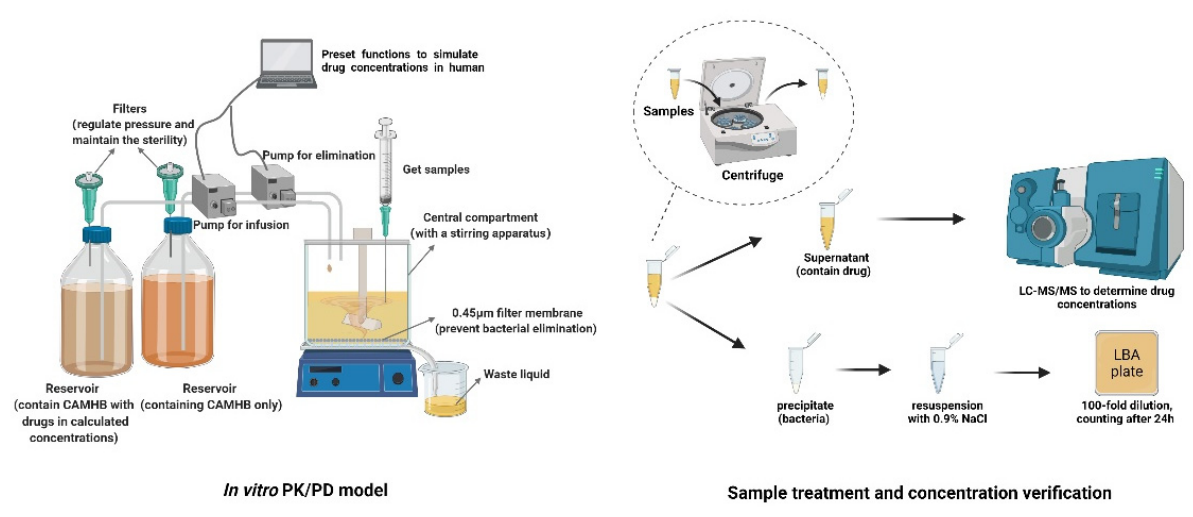
Figure 3. Experimental apparatus and process diagram.